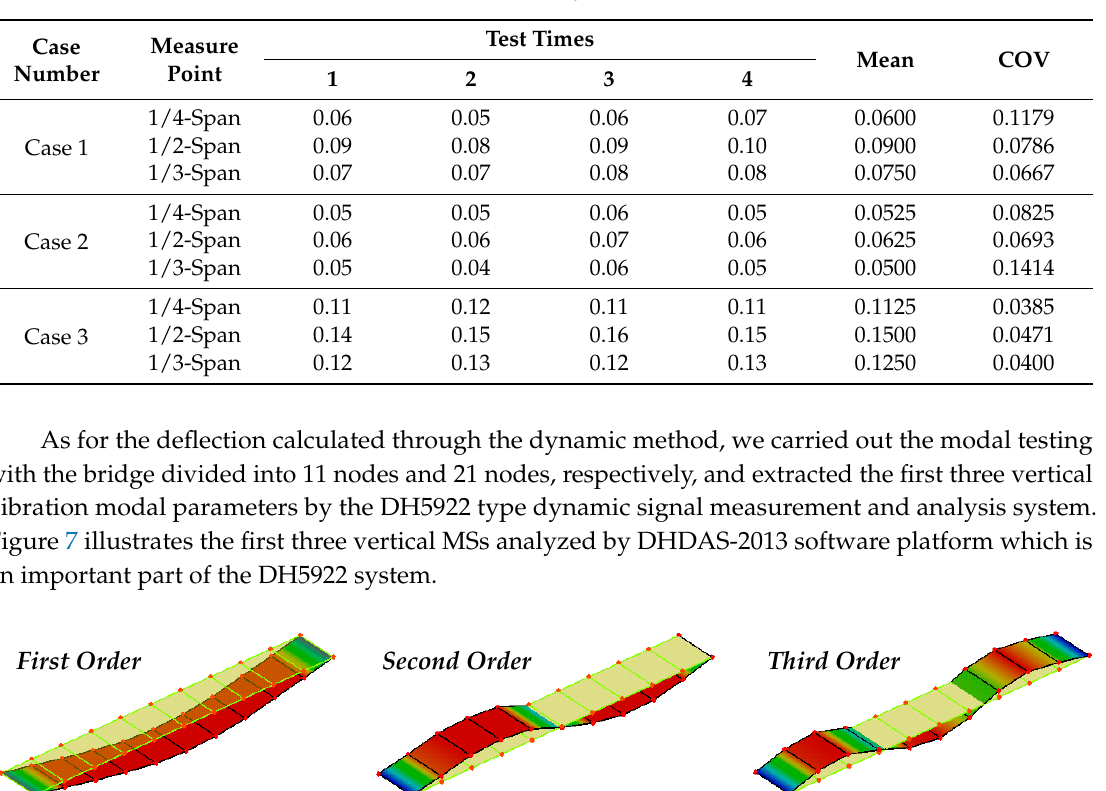
Table 2. Deflection results measured by static test method (unit: mm).